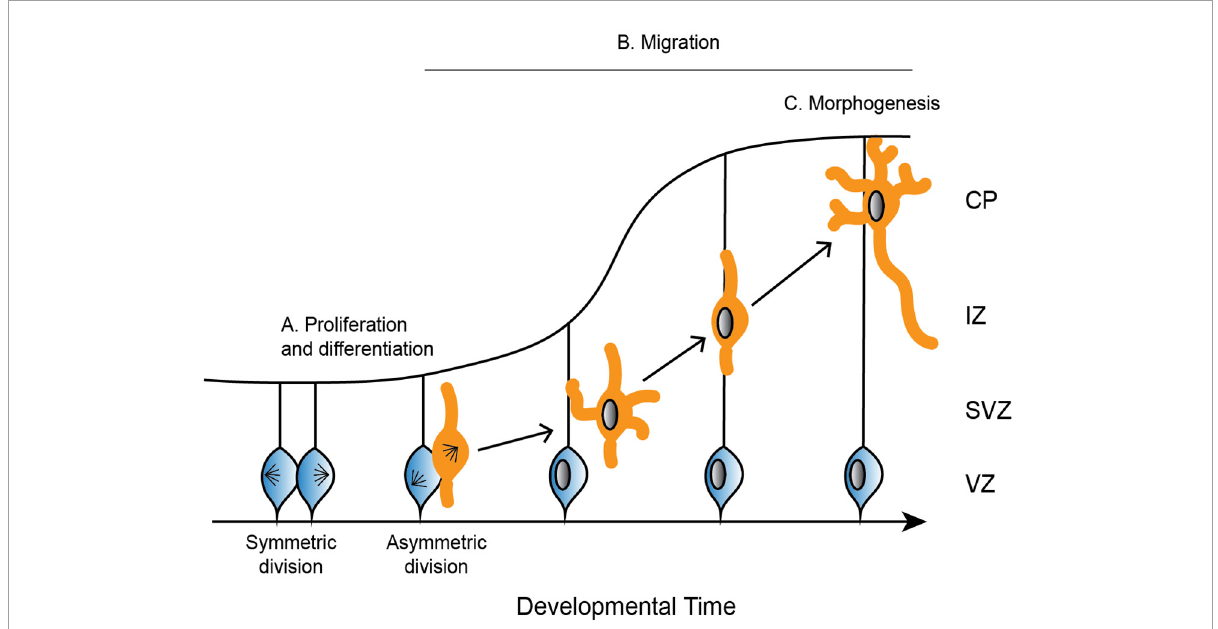
FIGURE2 Depiction of the development of the cerebral cortex. (A) Neural progenitor cells (blue) undergo symmetric and asymmetric divisions before differentiating into specific cell populations, such as neurons (orange). (B) Neurons radially migrate along glial cells from the ventricular zone (VZ) to the cortical plate (CP). Neurons are bipolar in the VZ before switching to a multipolar state in the subventricular zone (SVZ). To continue radial migration, neurons then revert back to a bipolar state through the intermediate zone (IZ) until they reach the developing CP. (C) Upon reaching the CP, neurons undergo further morphogenesis, including maturation of the axon and extension of multiple